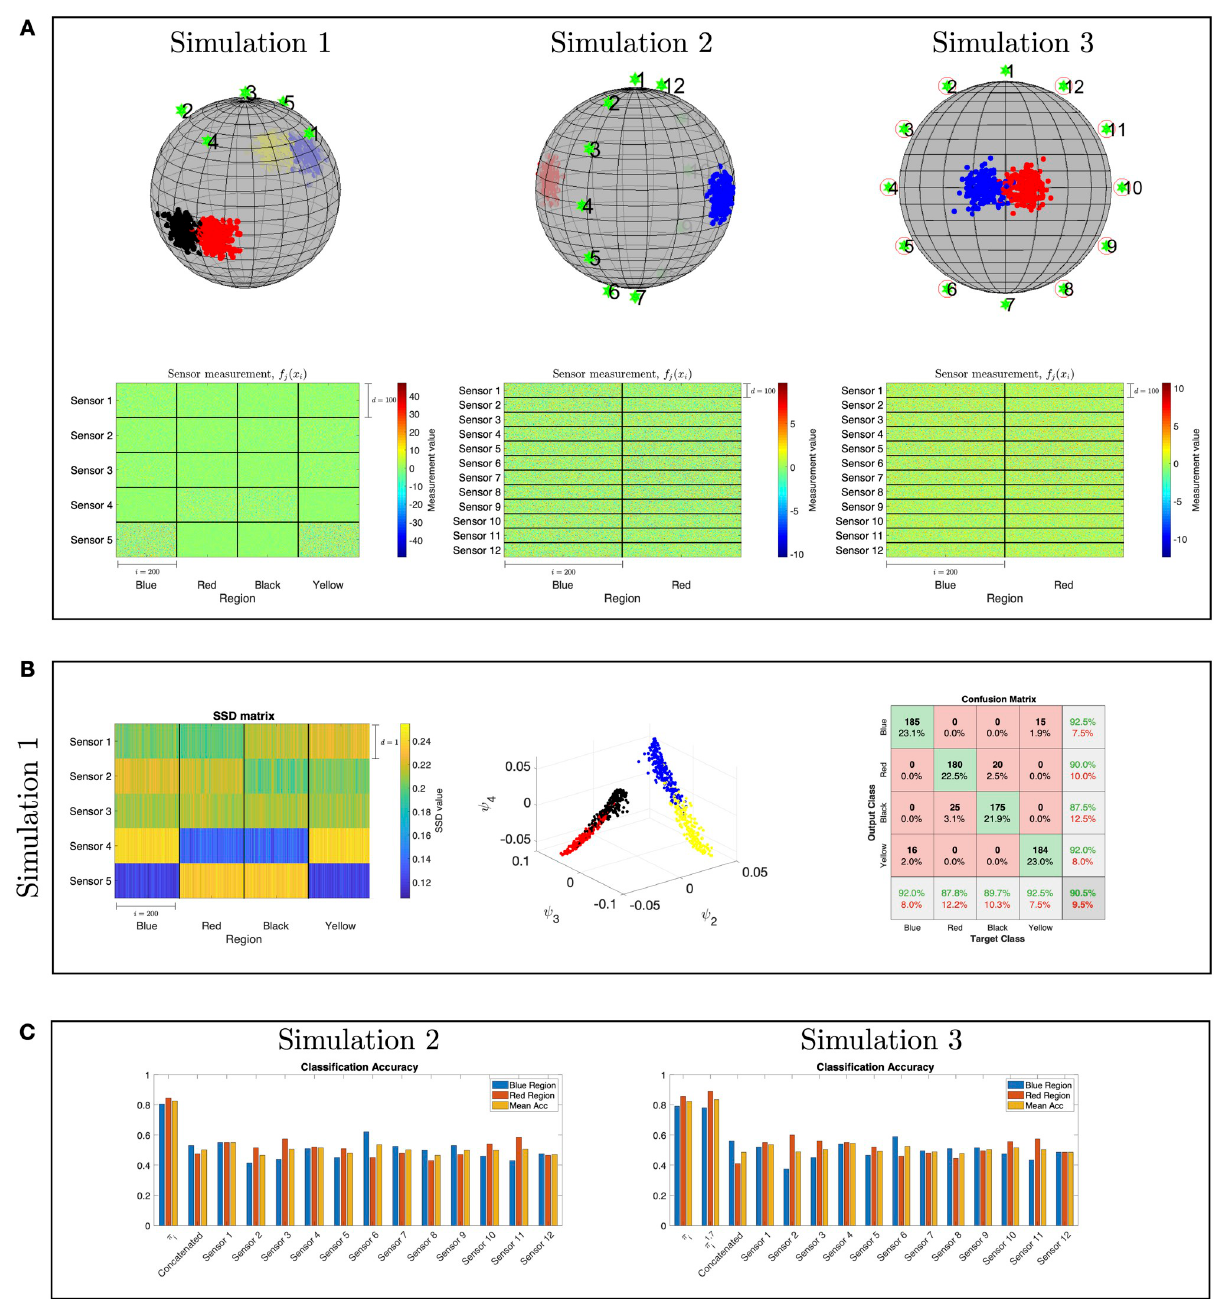
Fig 4. Illustration of localization toy problems. (A) The sensors and objects locations on a sphere are marked by green stars and dots, respectively. The multi-sensor observations correspond to Simulation 1 (left), Simulation 2 (middle), and Simulation 3 (right). (B) Results of the application of our approach to Simulation 1: the SSDs obtained by the proposed method (left), the diffusion maps embedding (middle), and the localization confusion matrix obtained by a 10-fold cross-validation with an RBF SVM classifier (right). (C) A comparison between the localization accuracy obtained by the proposed method based on SSDs and the localization accuracy obtained based on the output of each sensor as well as the concatenation of the output from all the sensors. The localization accuracy is the number of correctly identified positions divided by the true number of total positions in each